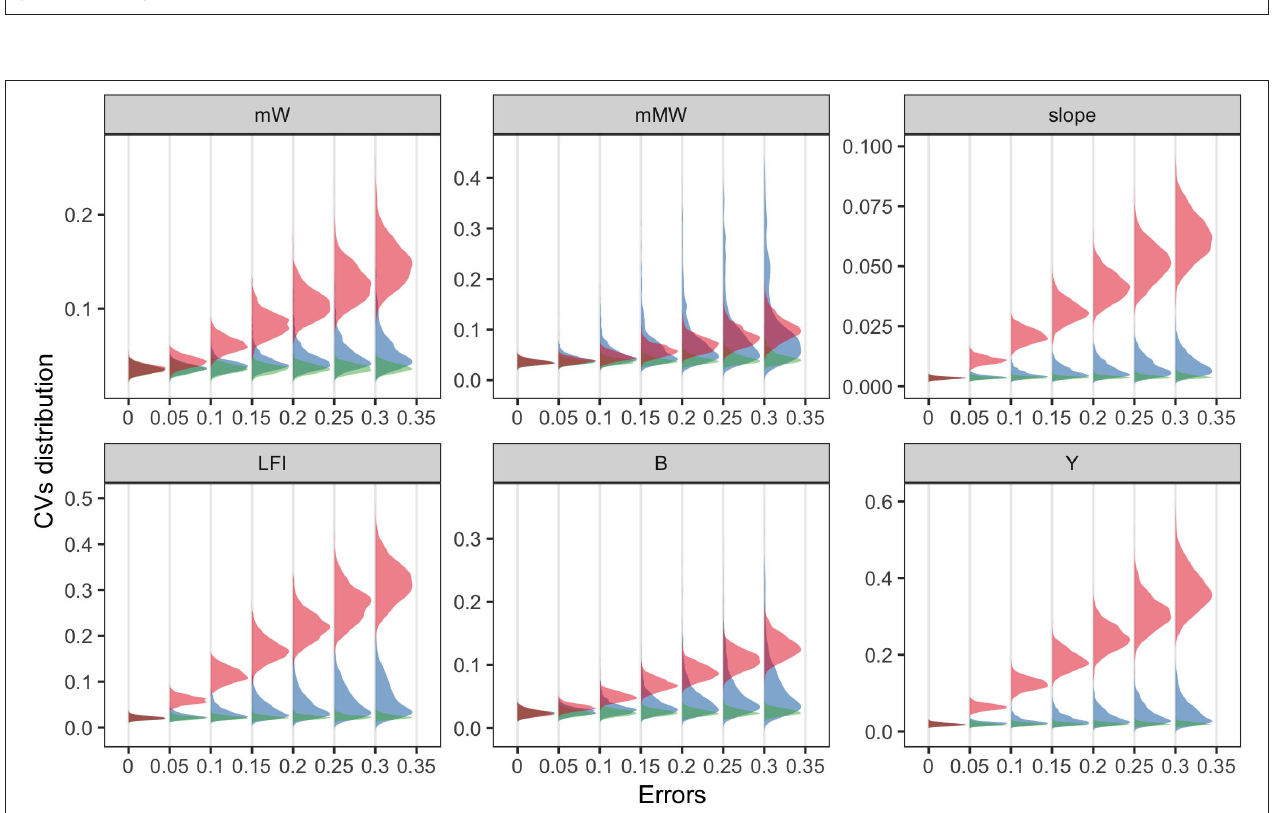
FIGURE 4 | Coefficient of variations (CVs) of ecological indicators driven by the errors of three model parameters (fishing effort, E in red; the maximum recruitment, r_max in blue; and the diet selection width, sigma in green). Ecological indicators included the mean weight, mW; the mean maximum weight, mMW; the slope of size spectrum, slope; the large fish index, LFI; the total biomass, B; the total yield, Y. X-axis denoted the level of parameter uncertainty.